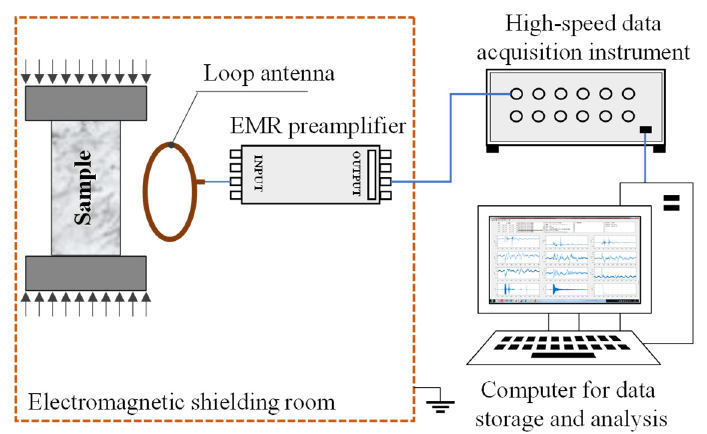
Figure 12. Schematic diagram of the experimental system.